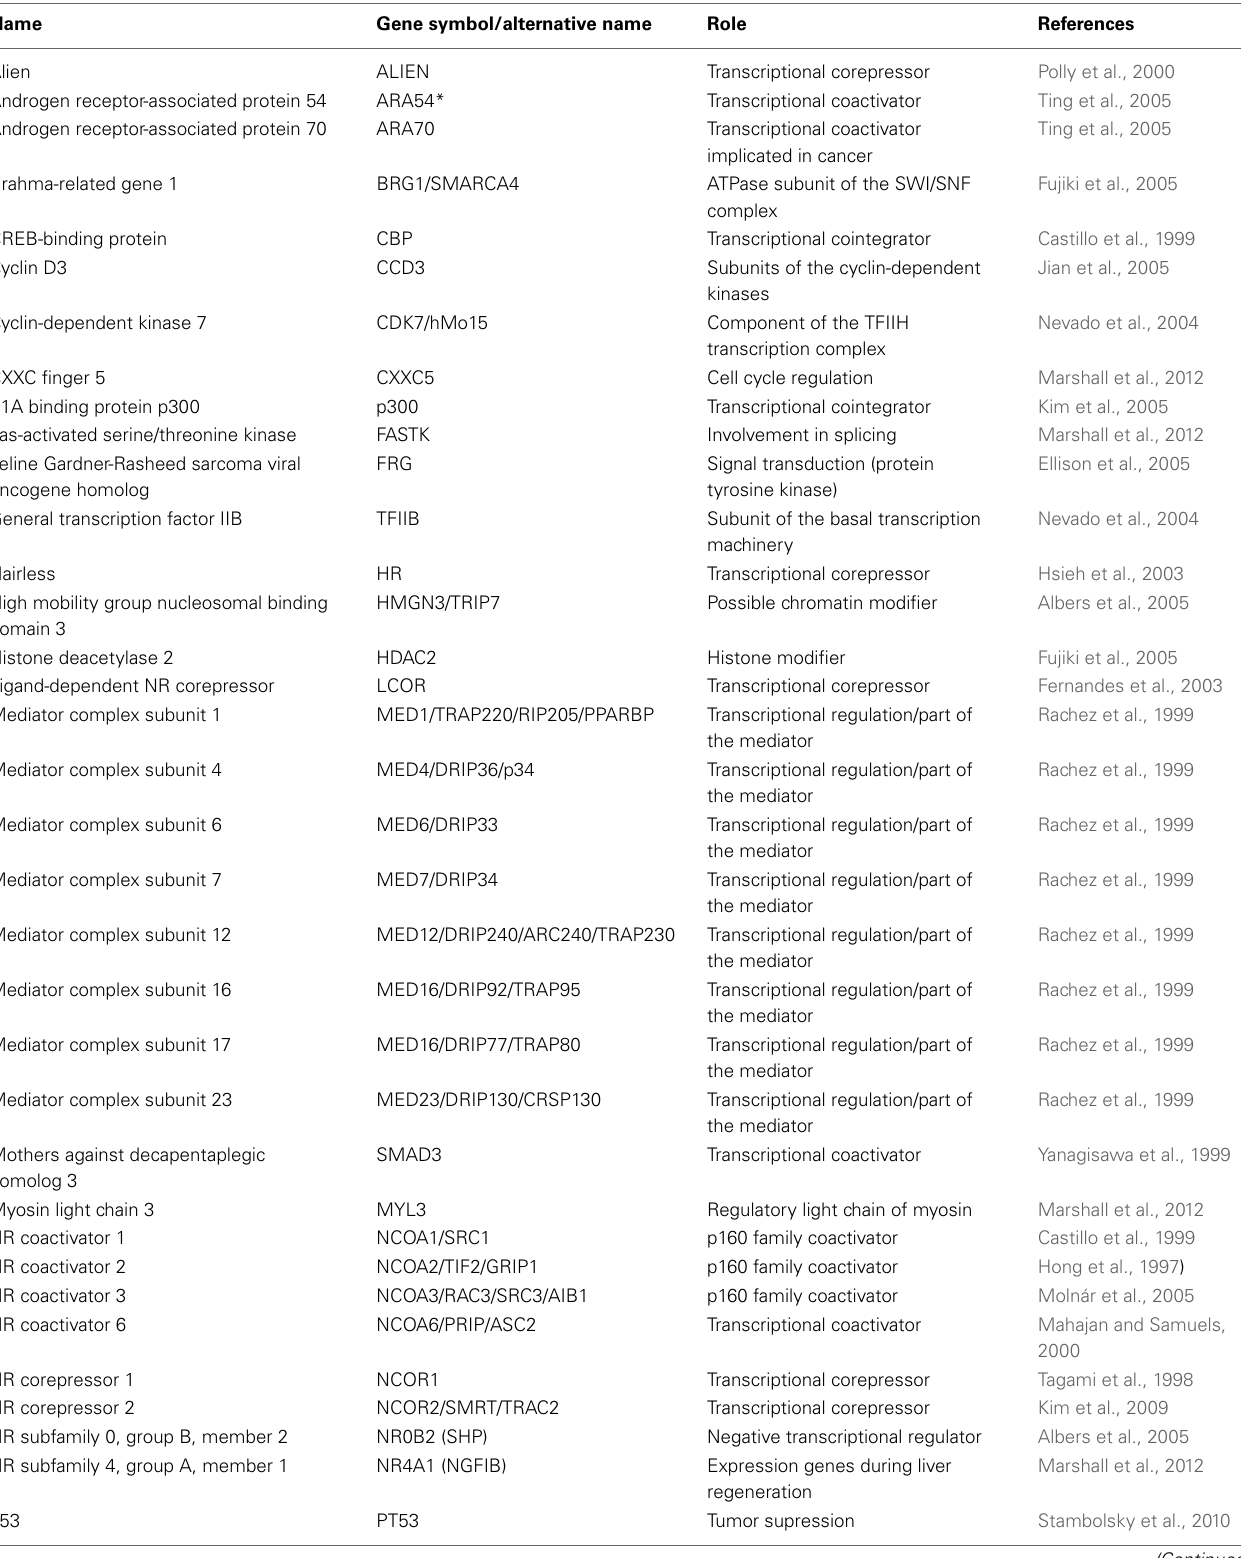
Table 2 | List of VDR interacting